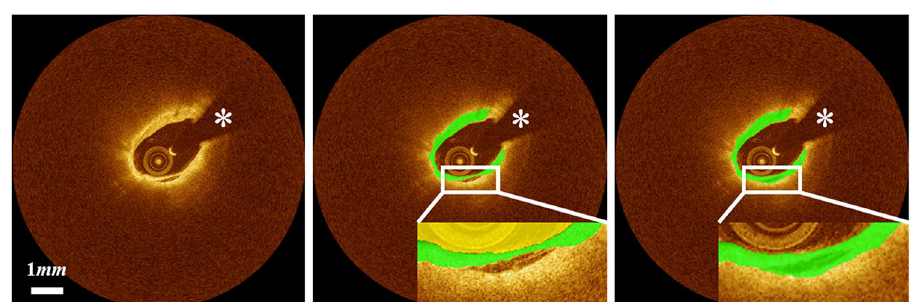
Figure 7. Challenging cases in fibrous cap detection requiring editing. Fibrous cap detection was not reliable when the lipid label includes other regions such as tissue dissection. The left, center, and right panels are original image, automated result, and manually edited results, respectively. Green is the fibrous cap, and white asterisk (*) indicates the guidewire